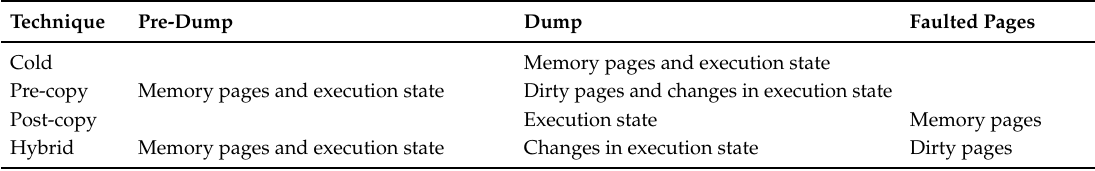
Table 1. What is transferred in each phase of the migration techniques.